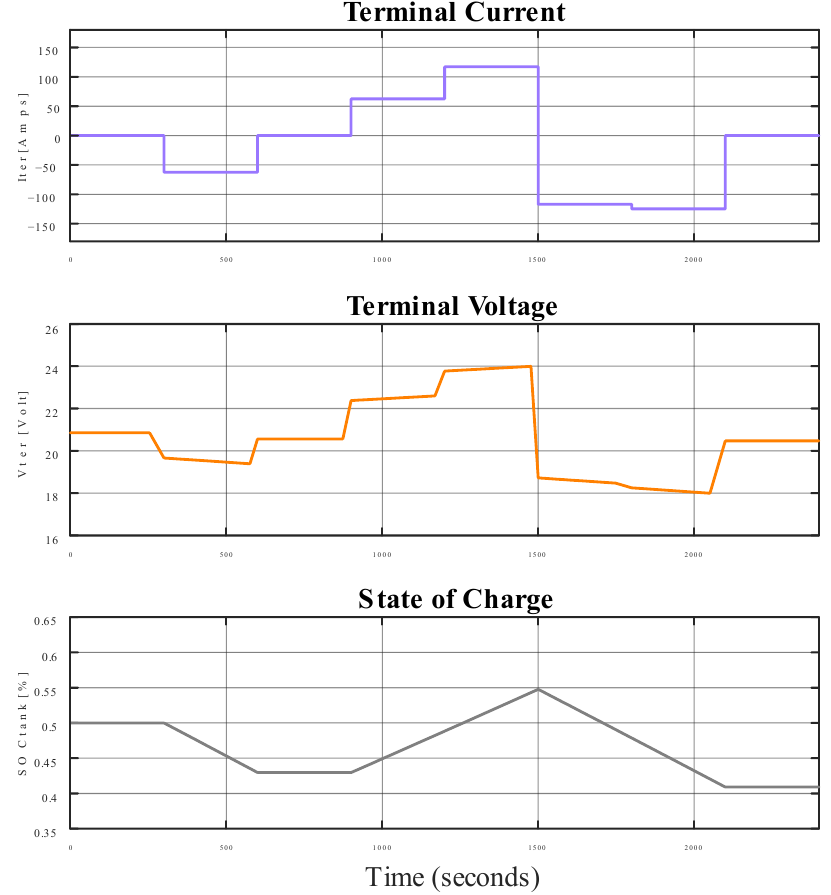
Figure 6. Battery response under current steps when the flow rate equals 4 [L/min].